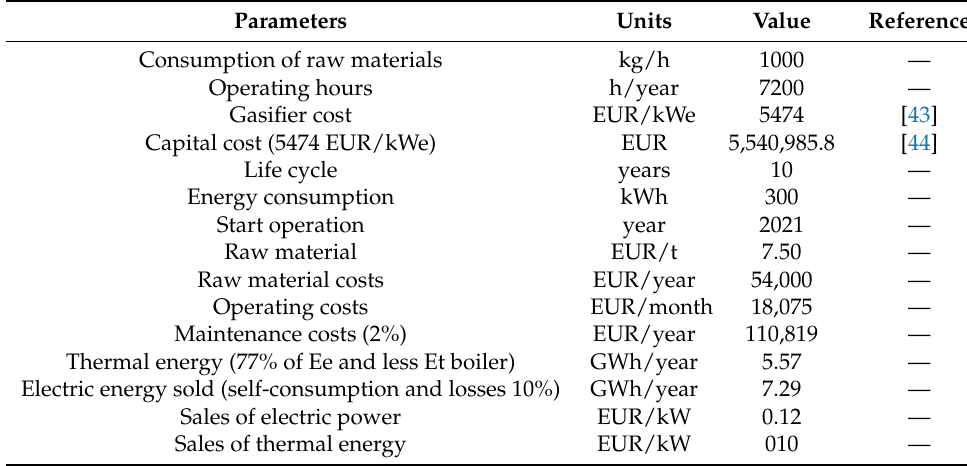
Table 2. Initial assumptions for the gasification